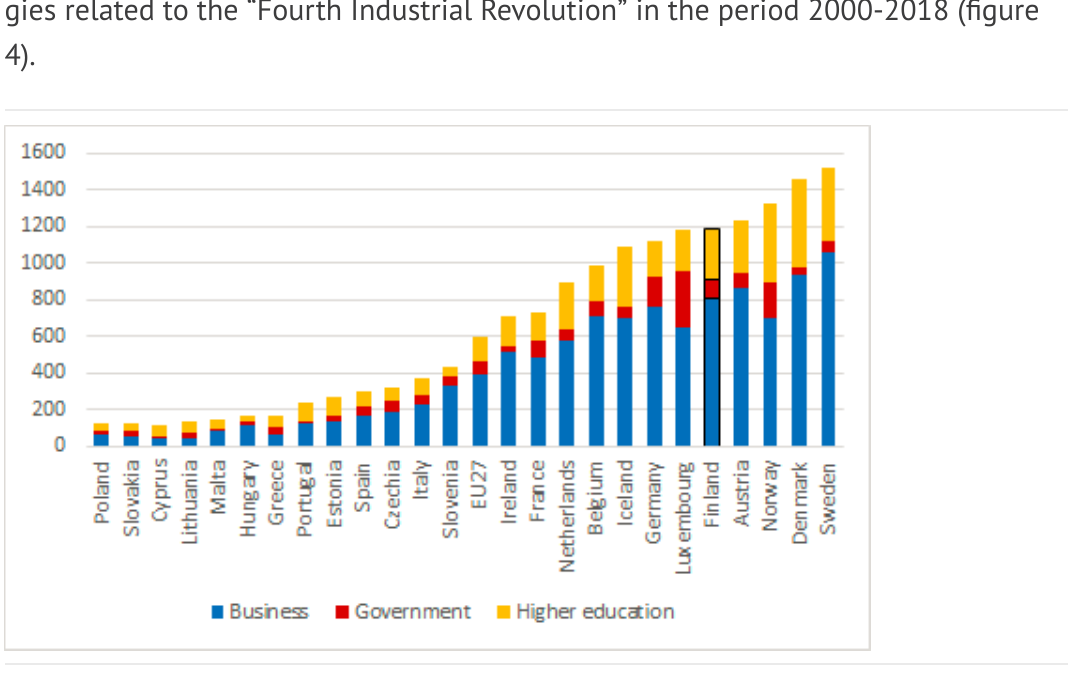
FIGURE 3: Average R&D (€) per million inhabitants, 2011-2020 (EUROSTAT,